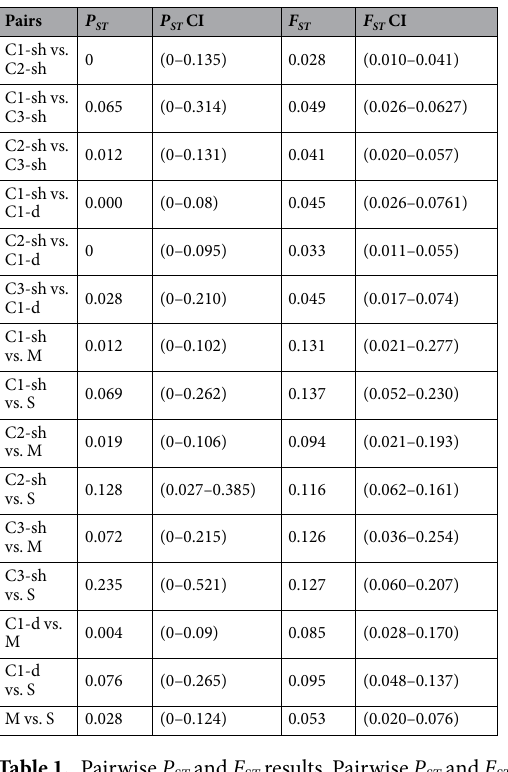
Table 1. Pairwise P ST and F ST results. Pairwise P ST and F ST results with their corresponding 95% confidence intervals (CI). C1-sh, C2-sh and C3-sh: Calanques 1, 2 and 3 shallow, C-d: Calanques 1 deep, M: Medes, S: Scandola.